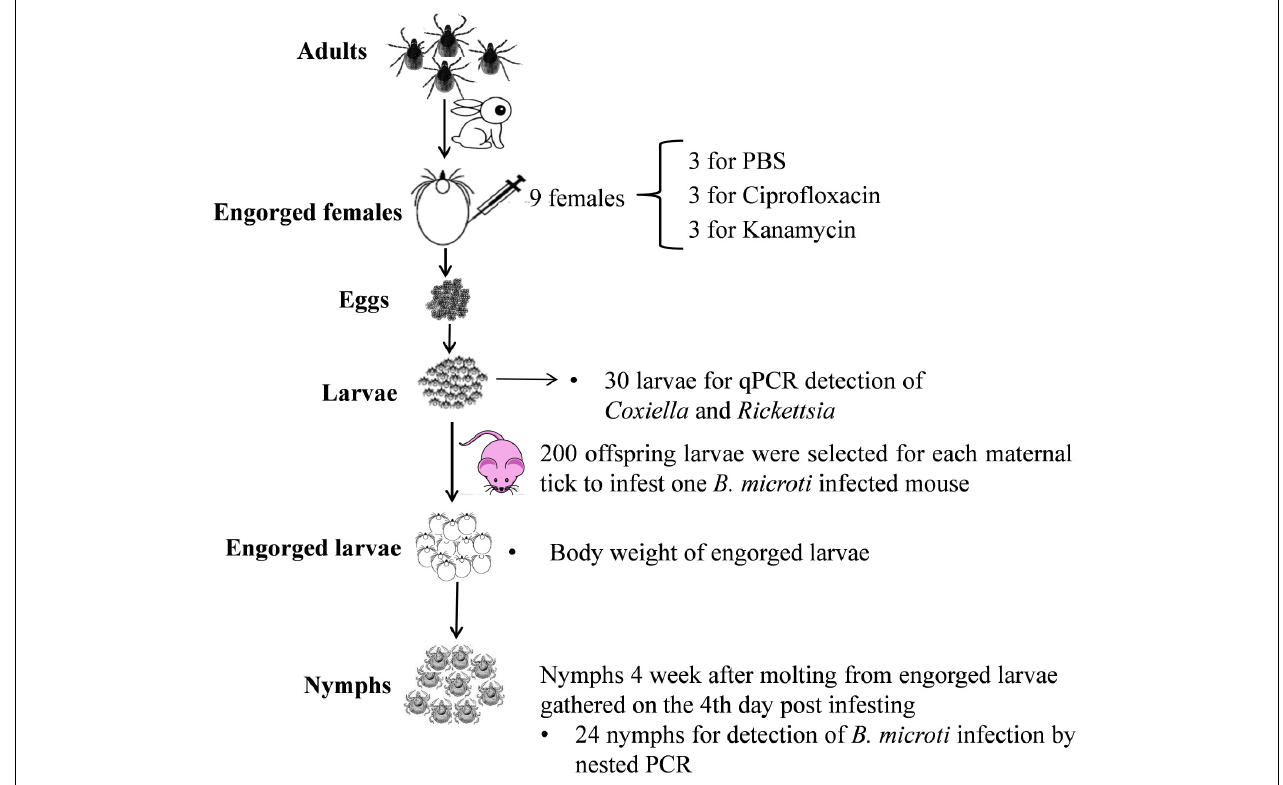
FIGURE 1 | Larva-to-nymph transmission experiments of B. microti through endosymbiont-disrupted R. haemaphysaloides larvae.